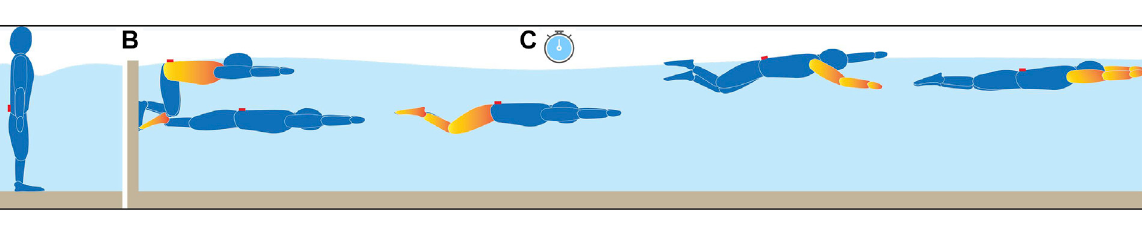
FIGURE 1 Measurement protocol with IMU (red box) attached to the sacrum. After functional calibration, the swimmer starts in the water with an upright posture (A) andperformsallswimmingphasesatmaximumspeedwhileswimmingtotheothersideinfrontcrawl (B) .Thecoachrecordsthelaptime with a stopwatch during each lap (C)